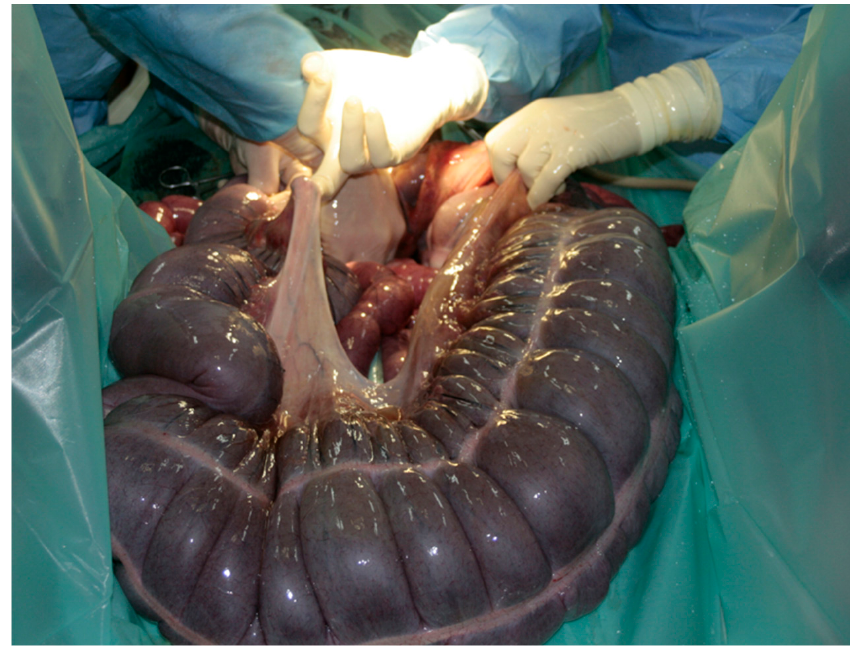
Figure 2. Defect of the left mesentery (after removal of the small intestine loop and transverse colon).